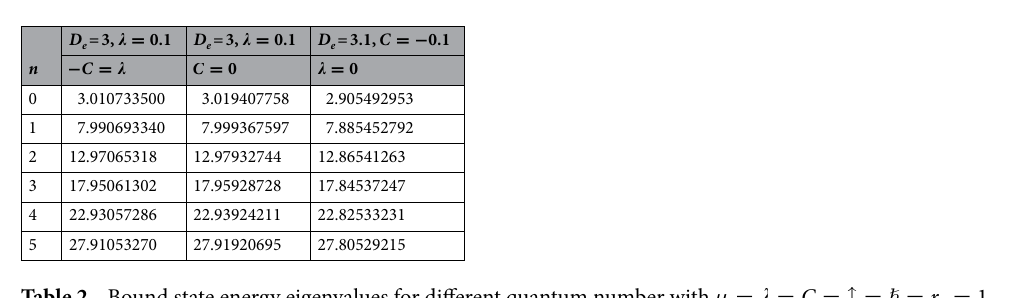
Table 2. Bound state energy eigenvalues for different quantum number with µ = (cid:31) = C = (cid:31) = ℏ = r e = 1.